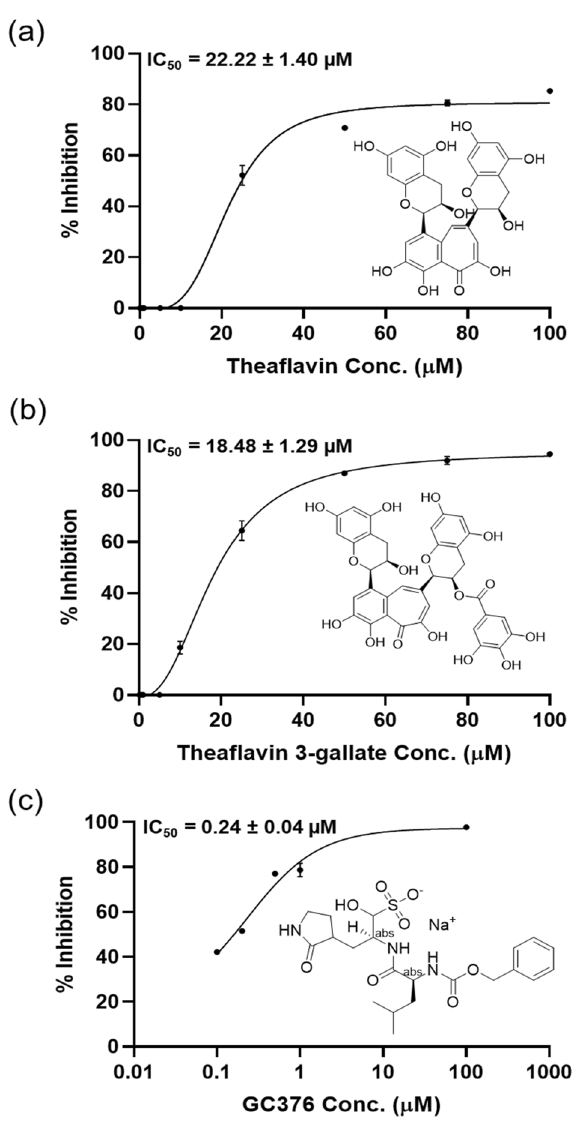
Figure 1. Inhibition of M pro protein of SARS-CoV-2 by theaflavin 3-gallate. The inhibition of M pro protein by ( a ) theaflavin (positive control), ( b ) theaflavin 3-gallate, and ( c ) GC376 (positive control) was measured in the presence of increasing concentrations of these molecules. The structures of molecules are shown along with the IC 50 curves. Dose–response curves for IC 50 values were determined by non-linear regression. Data represent mean ± SE, n = 3 independent